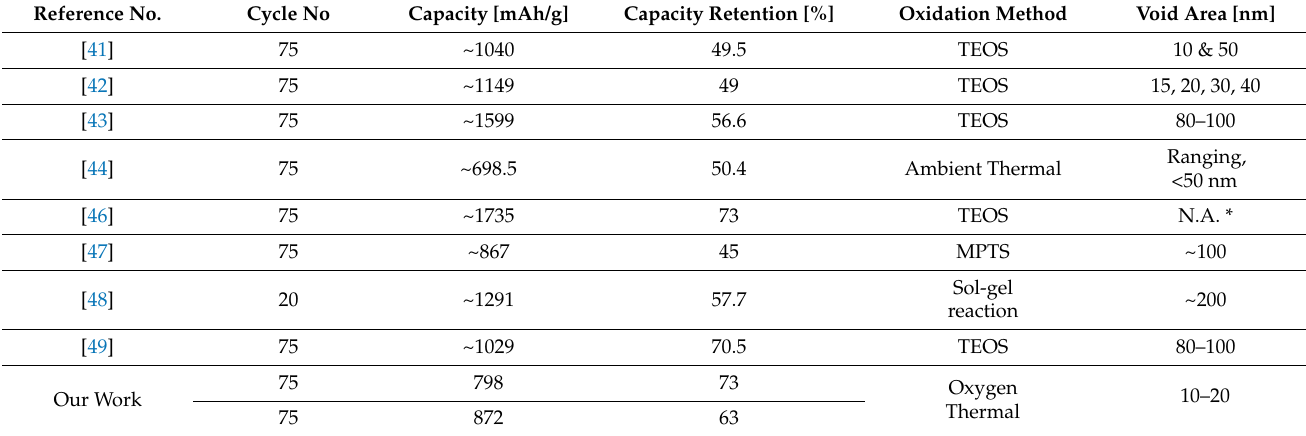
Figure 4. ( a , b ) Discharge gravimetric specific capacity in ( a ) CR2032 coin-type half-cells and ( b ) Swagelok ® T-type half-cells. ( c ) Coulombic efficiency for electrodes Si, Si_Gr, and Si/void_Gr in coin-type half-cells and ( d ) Gravimetric specific capacity as a function of the charge-discharge specific current for all electrodes. Table 2. Comparison of electrochemical performance between our work and the reported work. For fair comparison, the capacity retention after 75 charging/discharging cycles, if possible, was considered. It has to be noted that the C rates for all references ranged from 0.1 to 0.5